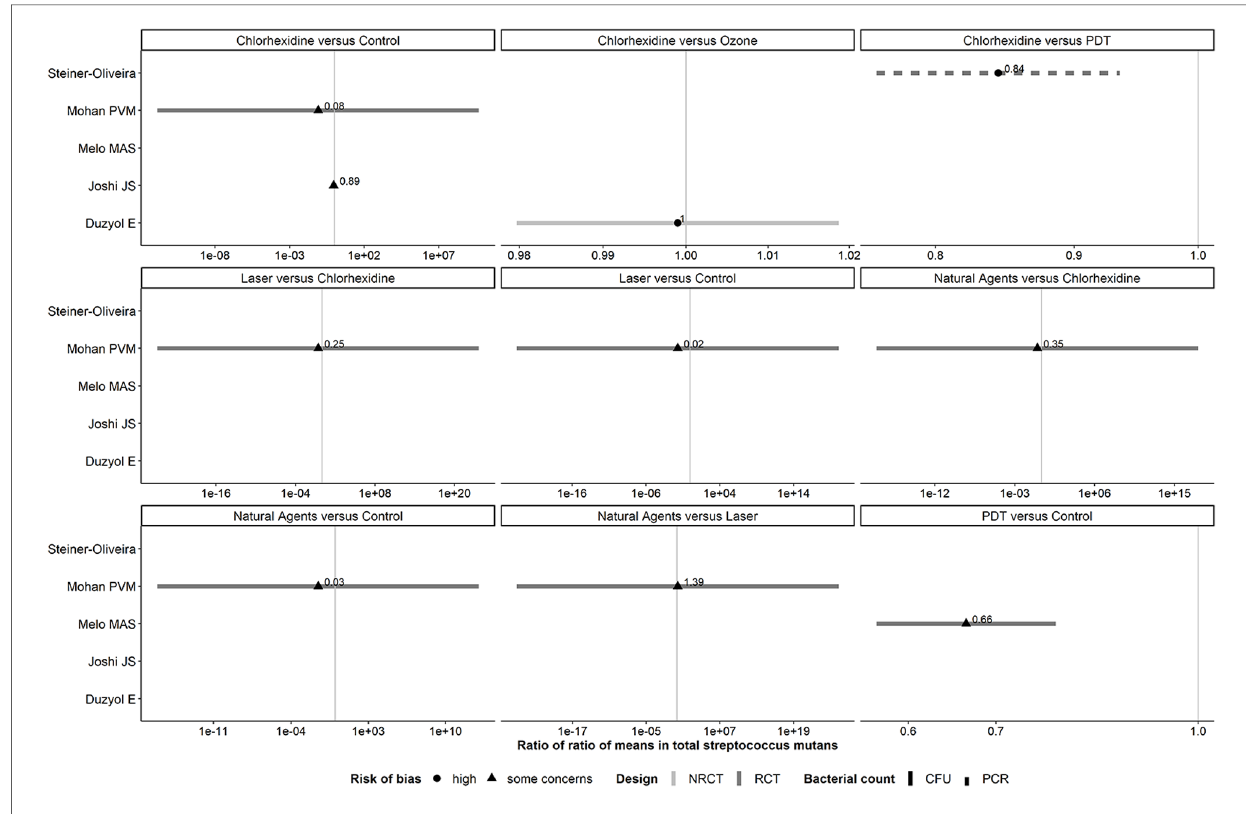
FIGURE 7 Forest plots showing roRoMs for Streptococcus mutans across the antiseptics